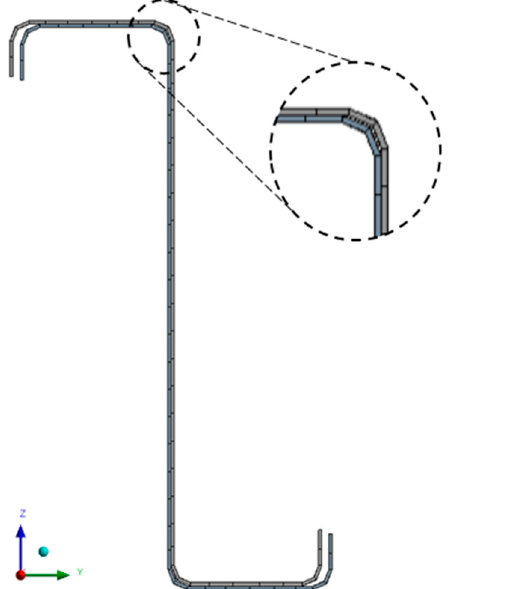
Figure 5. Schematic diagram of element SHELL181 [28].